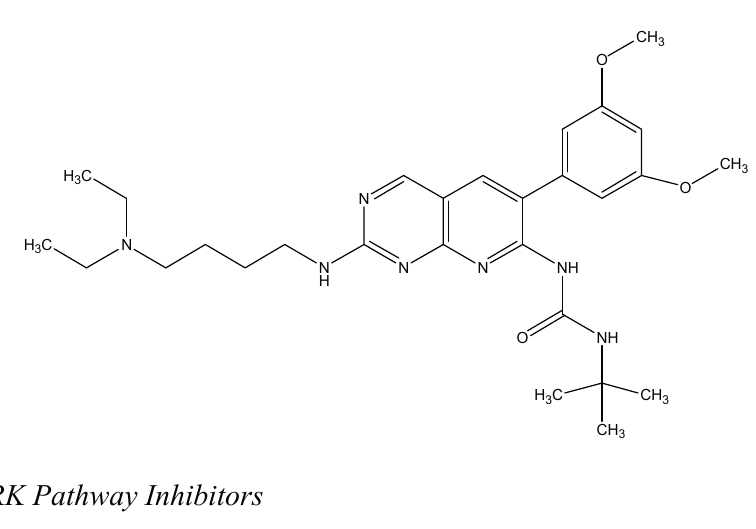
Figure 19. Structure of PD173074.